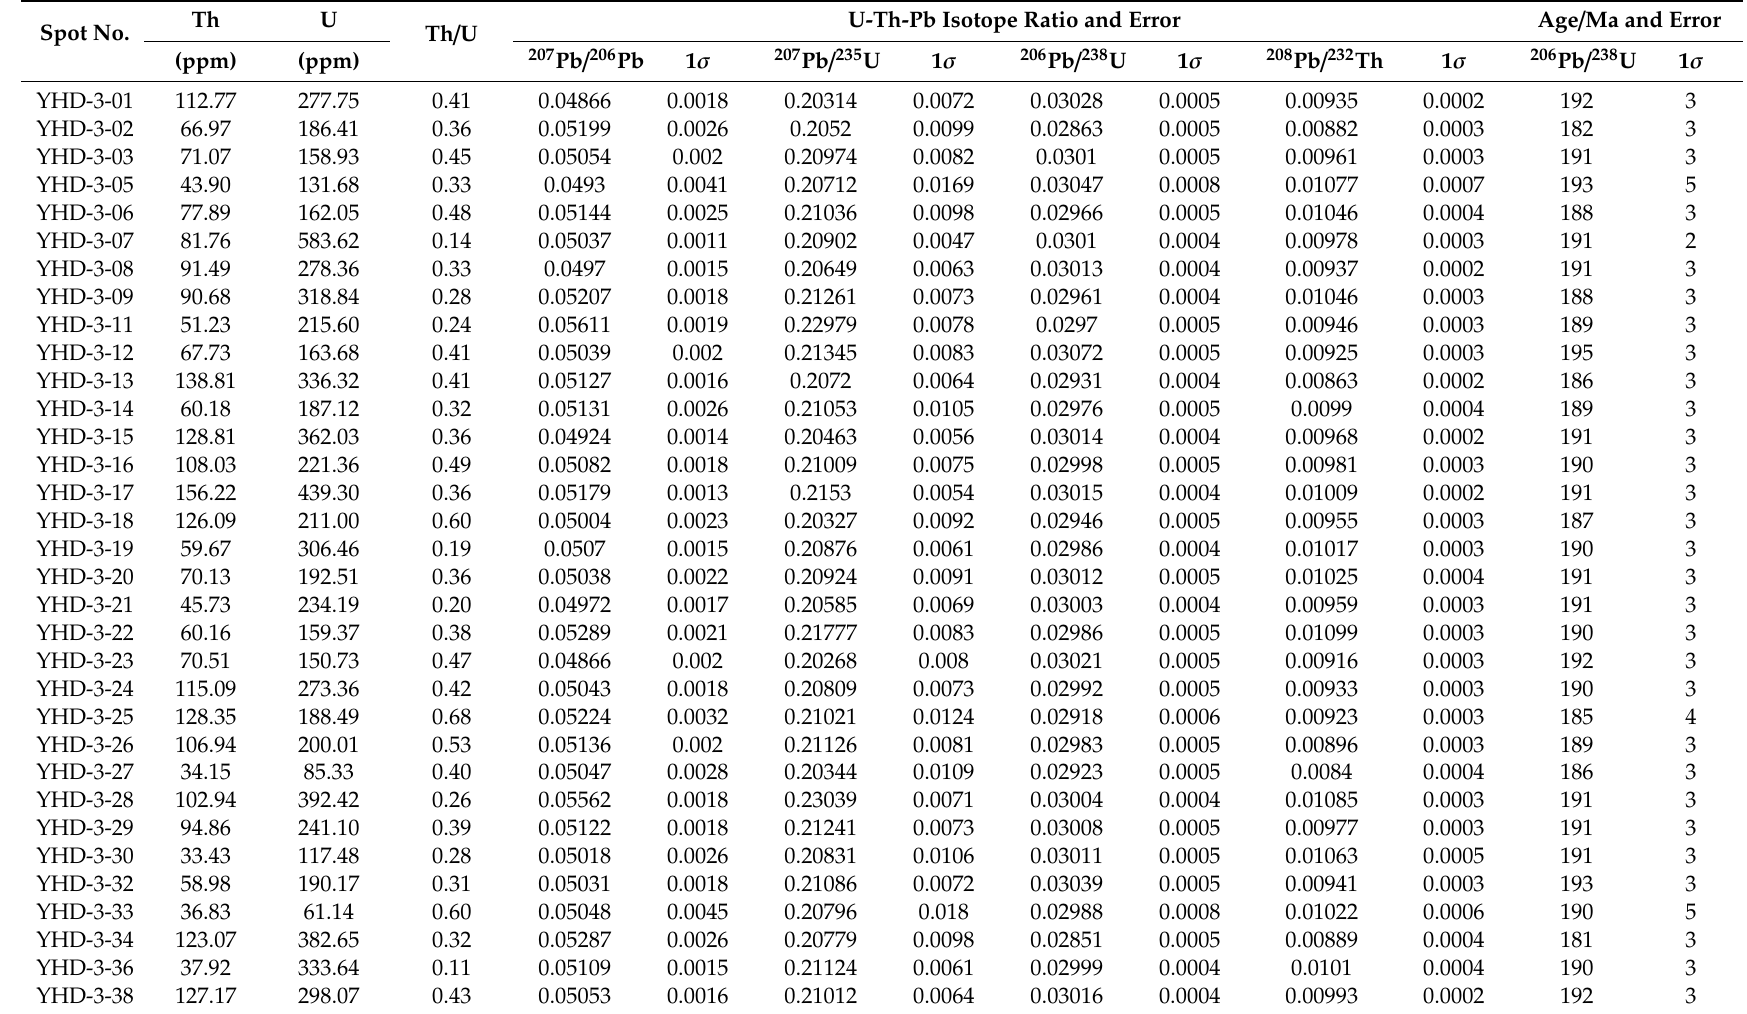
Table 1. Zircon LA-ICP-MS U-Pb analysis of granodiorite porphyries in the Yanghuidongzi